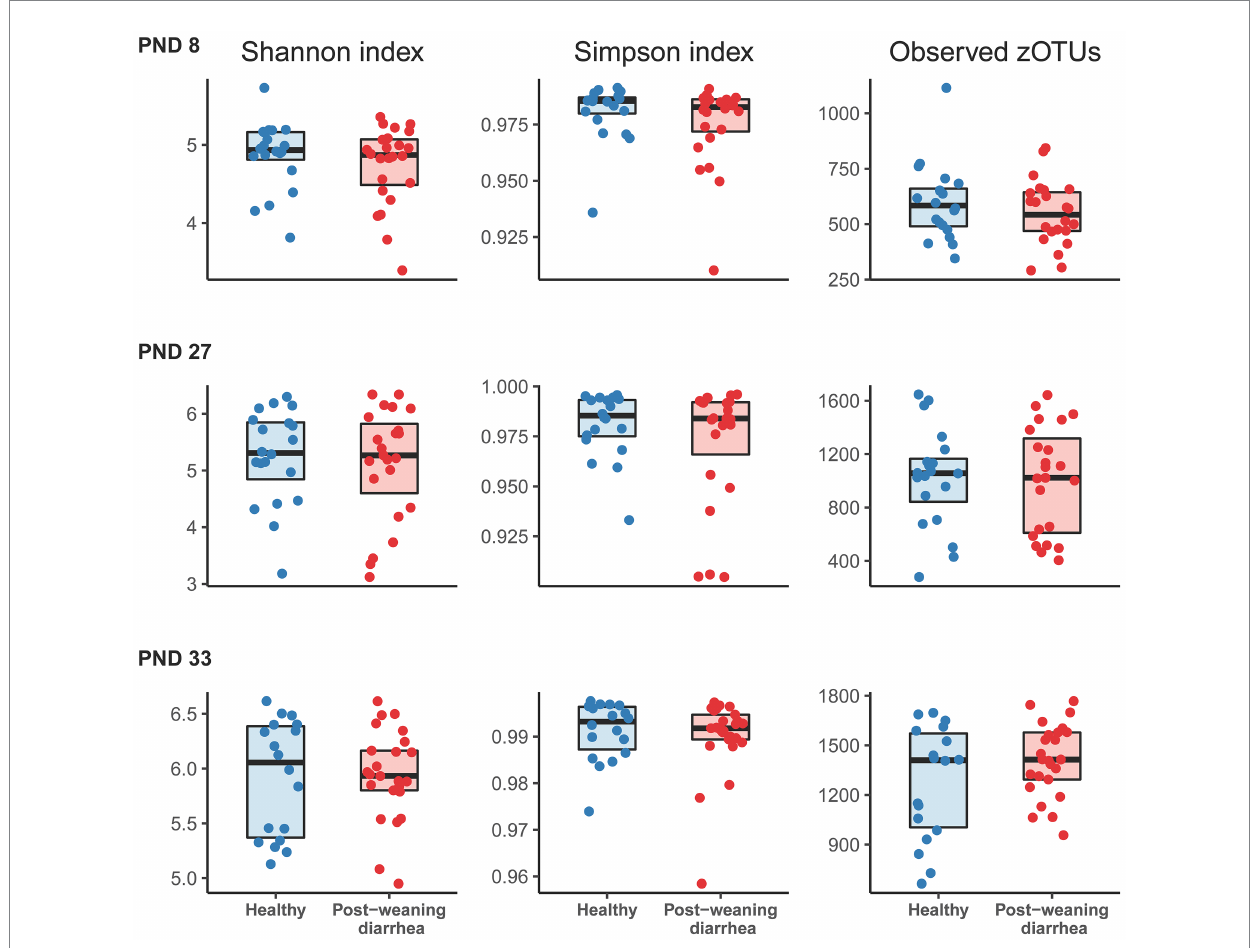
FIGURE 1 Comparison of alpha diversity indices based on post-weaning diarrhea (PWD) status. Groups were compared at post-natal day (PND) 8 (early lactation, healthy: n = 20 pigs, PWD: n = 24 pigs), at PND 27 (late lactation, healthy: n = 20 pigs, PWD: n = 23 pigs), and PND 33 (7 days after weaning, healthy: n = 18 pigs, PWD: n = 25 pigs). Shannon and Simpson indices and number of observed zOTUs were based on a rarefied zOTU table generated from 16S rRNA V3 high throughput amplicon sequencing. Graphs show boxplots with medians marked with bold line. Statistical differences between groups were assessed with linear mixed models. No significant group differences were found for PWD status at any time point. At PND 33, the covariable body weight at PND 33 was positively associated with increased Shannon diversity (effect size: 0.13, 95% CI: [0.068; 0.208], p = 0.0002), Simpson’s diversity (effect size: 0.001, 95% CI: [ − 0.00012; 0.002], p = 0.07), and number of observed zOTUs (effect size: 86.33, 95% CI: [46.27; 126.80], p =